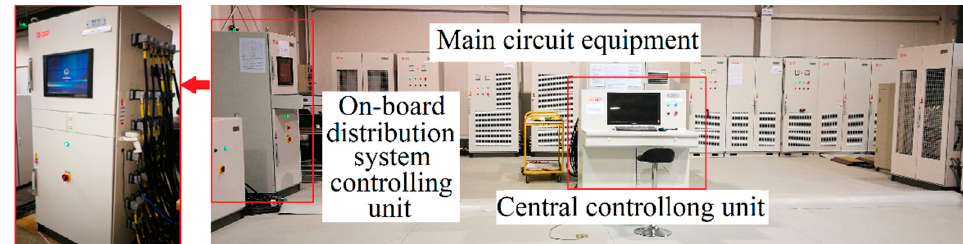
Figure 3. Maglev distribution system experimental platform.